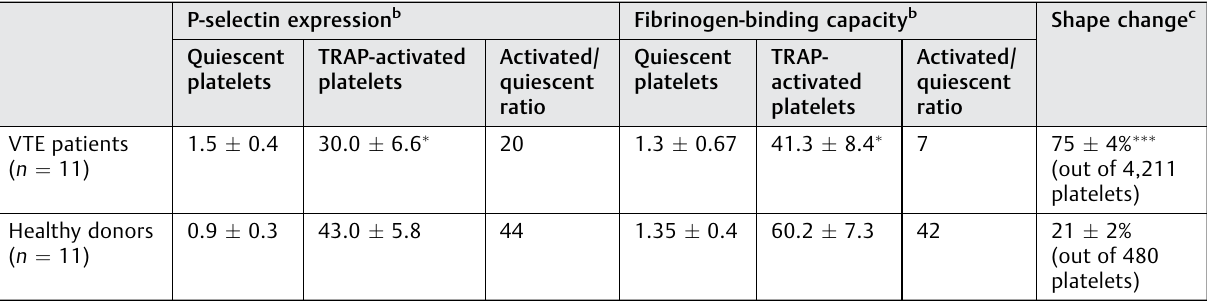
Table 3 Functional and morphological characterization of platelets isolated from the blood of VTE patients and healthy donors before and after activation with TRAP-6 a